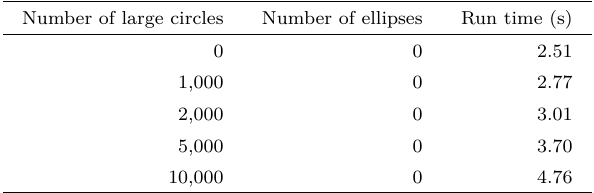
Number of large circles